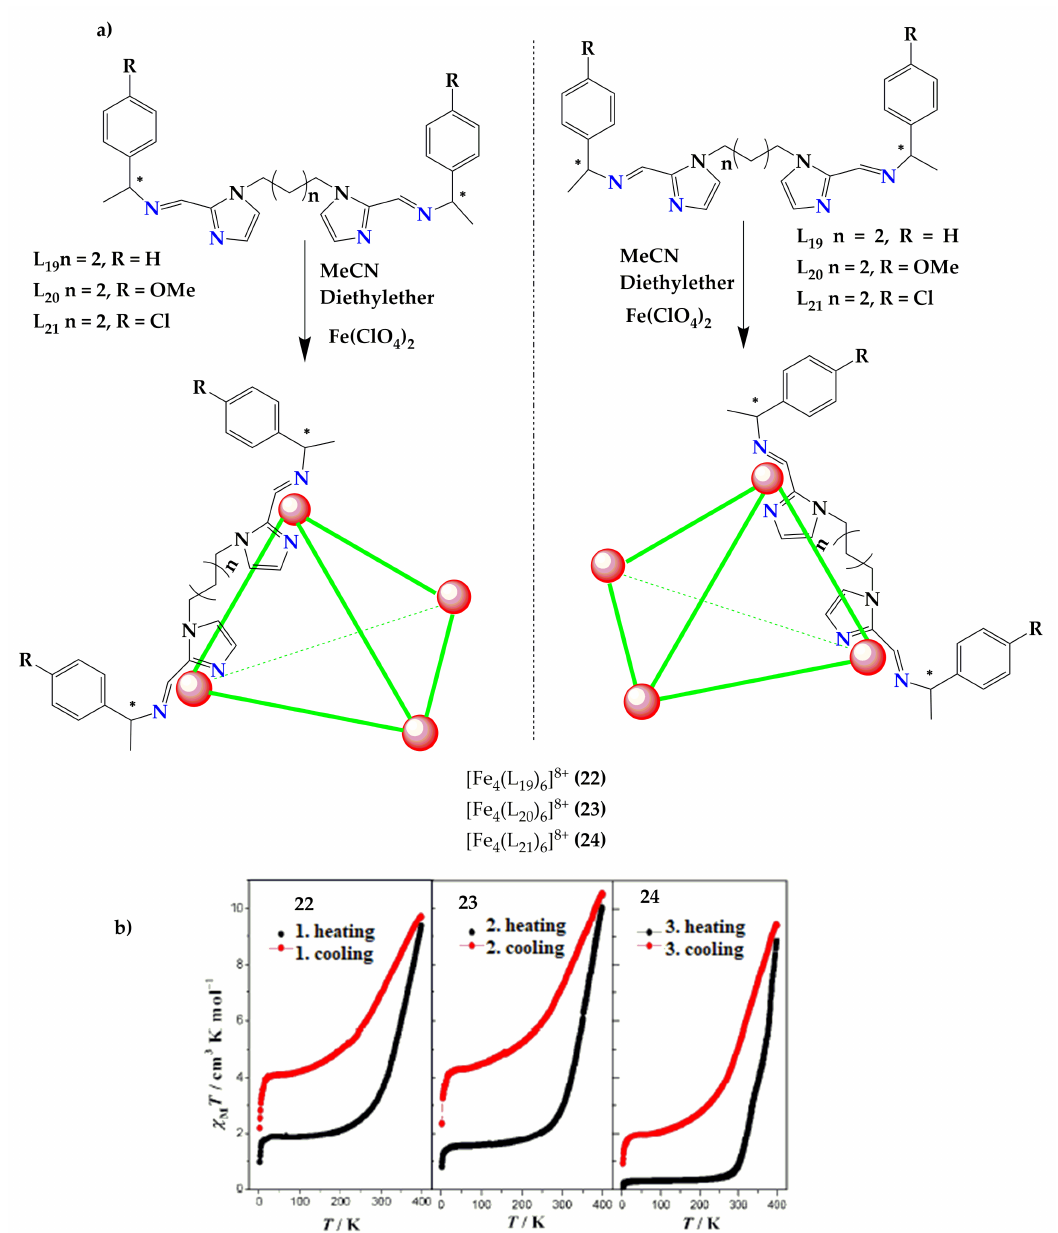
Figure 16. ( a ) Enantiopure tetrahedral cages of complex 22 , 23 and 24 synthesized through subcom- ponent self-assembly of 1,4-di(imidazole-2 carboxaldehyde) butane chiral phenylethylamine and iron(II) ions. ( b ) Plots of χ M T vs. T for cage complexes of 22 , 23 and 24. Reproduced with permission from [48]; Published by Royal Society of Chemistry,